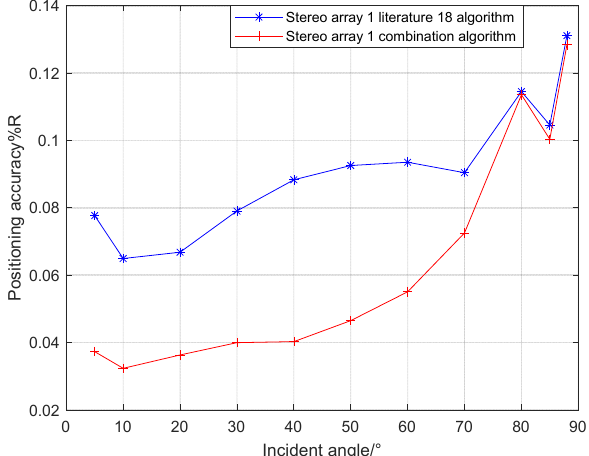
Figure 19. Comparison between combination algorithm and literature 18 algorithm for stereo array 1.